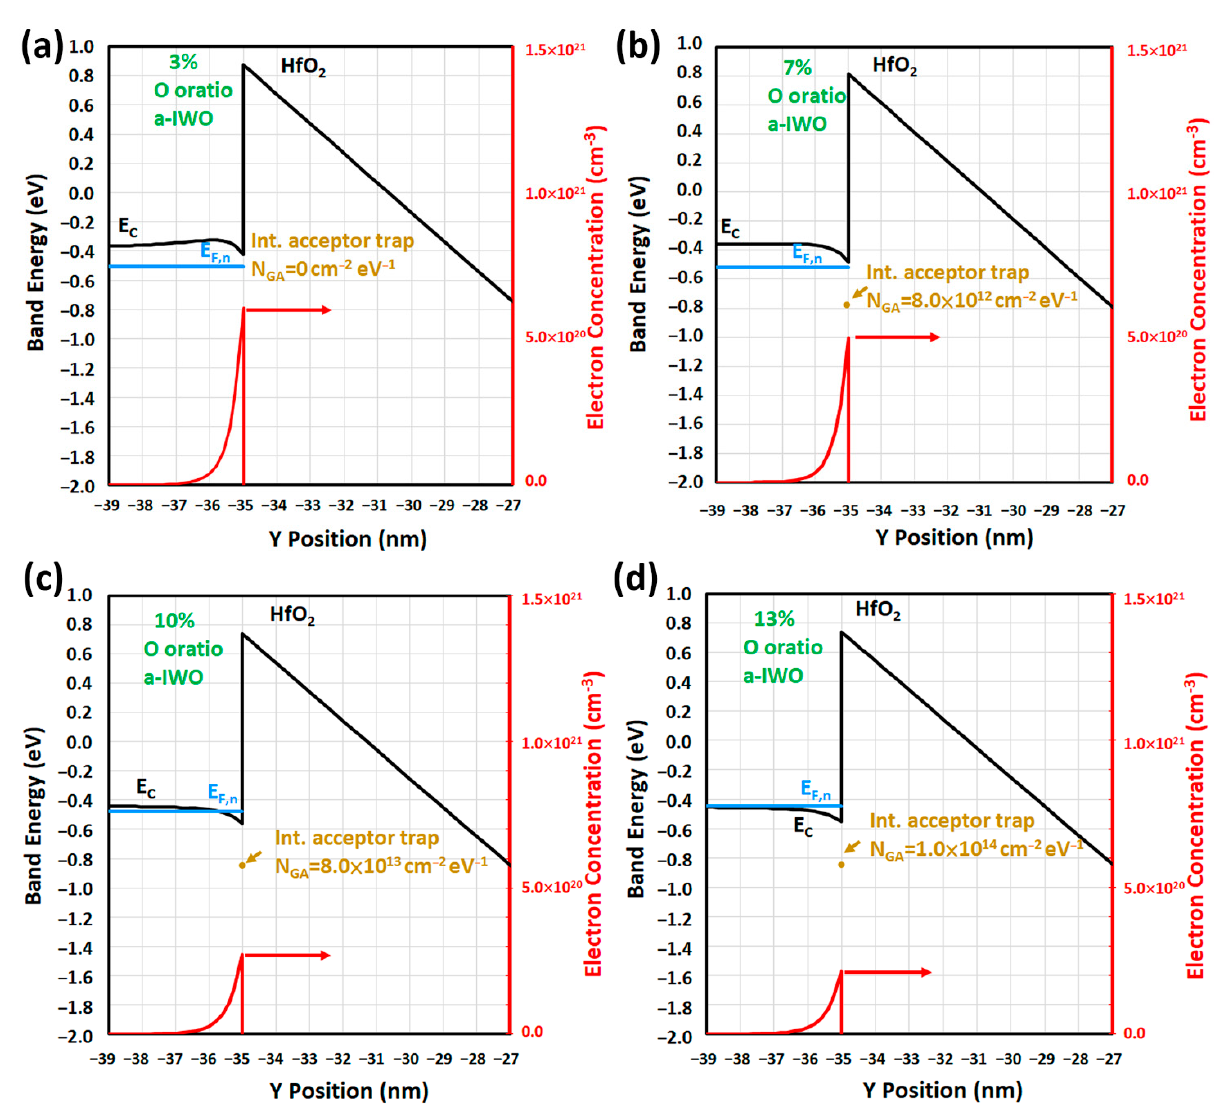
Figure 6. In the on-state (V G = 7V, V D = 0.1V, vs. = 0V), 1D band diagrams including electron quasi-Fermi level ( E F,n ) and electron concentration for ( a ) 3%, ( b ) 7%, ( c ) 10%, and ( d ) 13% of a-IWO TFT.